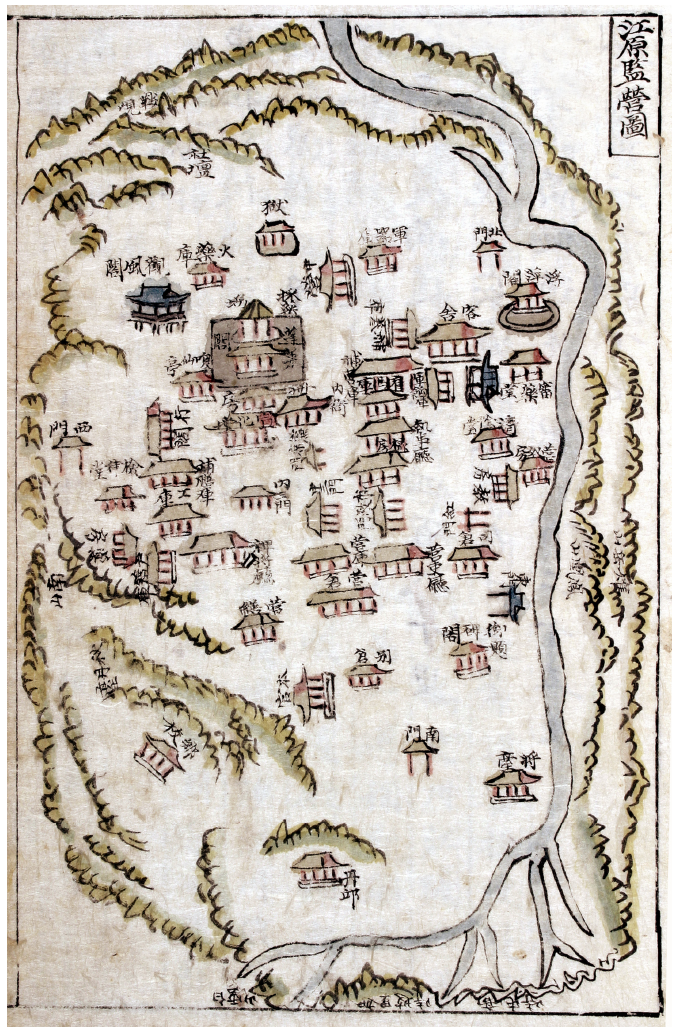
Figure 12. Map of Kangwŏn Provincial Office , Kwandong Gazetteer , Chosŏn period, 1820, Wŏnju City History Museum. Reproduced with permission from the W ŏ nju City History Museum.